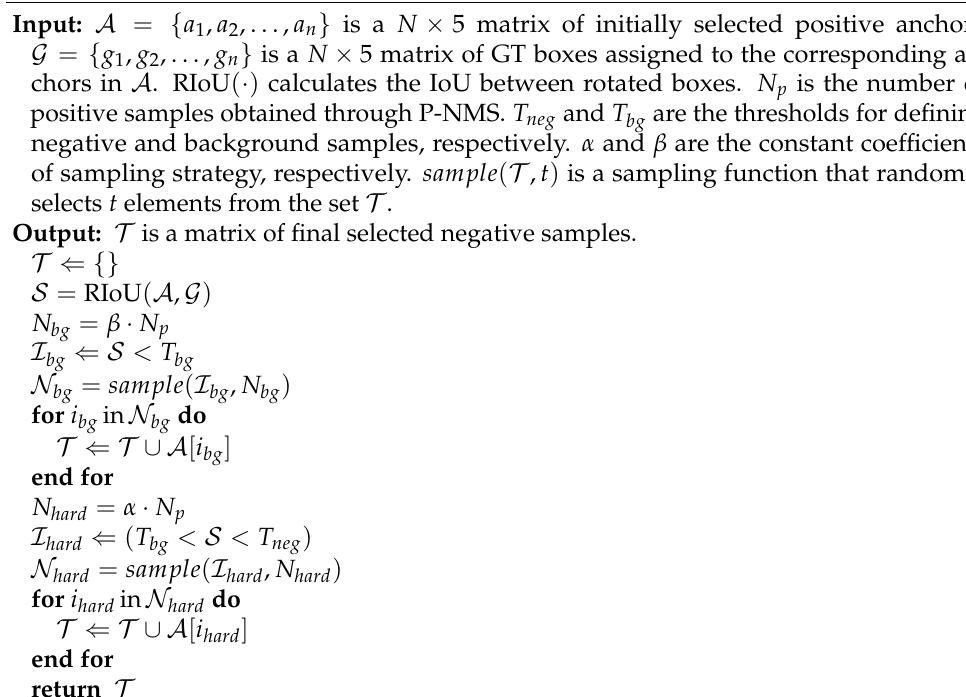
Algorithm 2 Representative sampling for negative